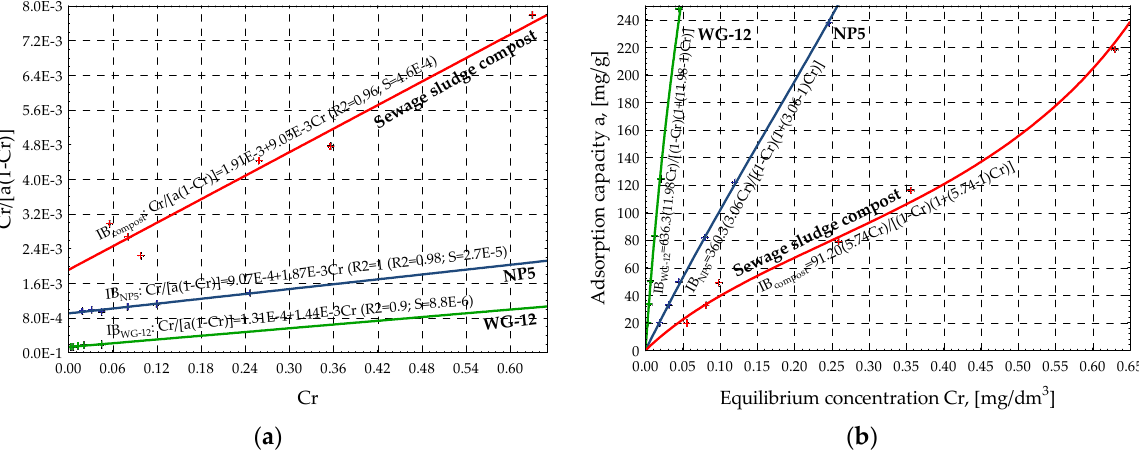
Figure 4. Graphs of linear isotherms ( a ) and classic isotherms ( b ) according to BET for tested sorbents.